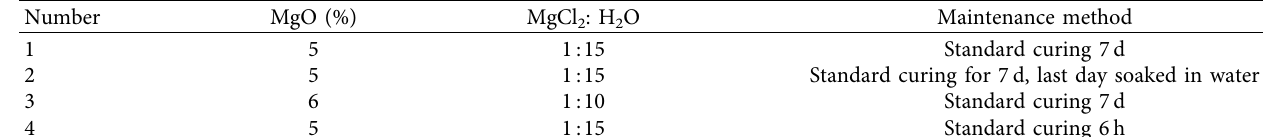
Table 5: Microscopic test sample design scheme.